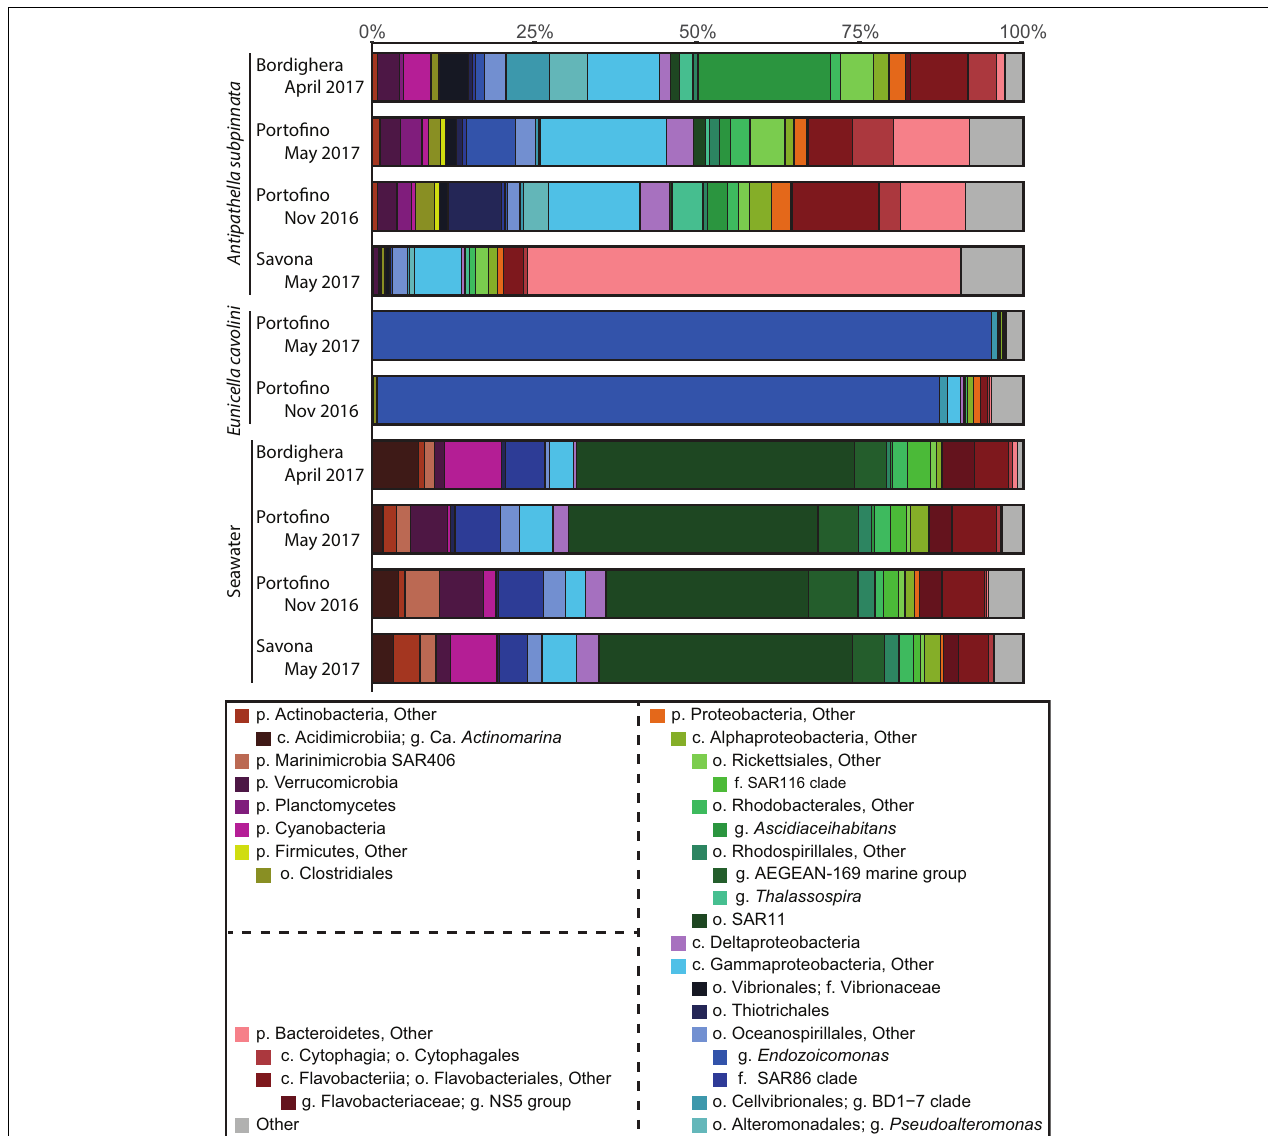
FIGURE 4 | Overview of the composition of the bacterial community associated with the black coral Antipathella subpinnata and in the seawater at three locations (Bordighera, Portofino and Savona), and at two time points (spring and autumn) at the Portofino location. The composition of the microbiota of the gorgonian Eunicella cavolini , living sympatrically with A. subpinnata at Portofino, is also provided. The composition of the microbial communities is presented at the various taxonomic levels (p, phylum; c, class; o, order; f, family; g, genus). The contribution of each taxon is indicated in percentages (%). Taxa with an abundance of < 1% were merged into its corresponding higher taxonomic level. Higher level taxa indicated with ‘Other’ (e.g., p. Proteobacteria, Other) include all subtaxa not specified below. Other (gray) contains all phyla with an abundance of < 1%.